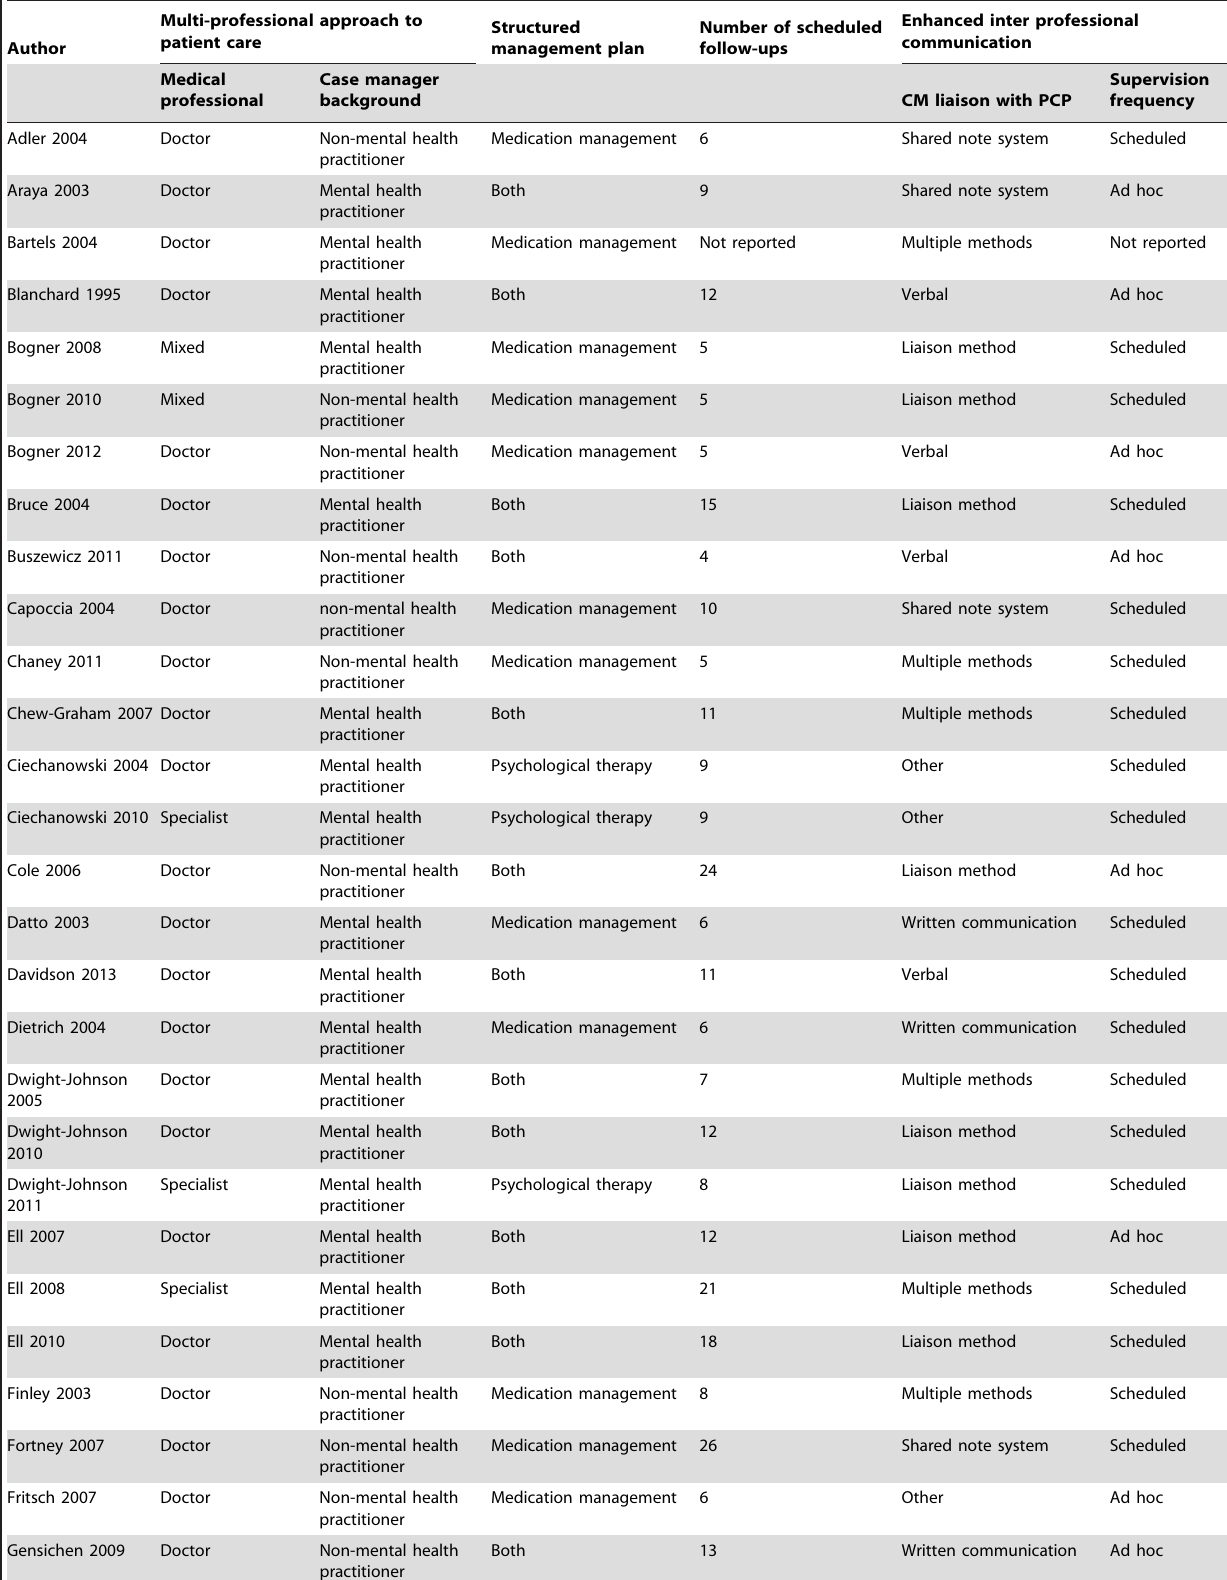
Table 3. Characteristics of collaborative